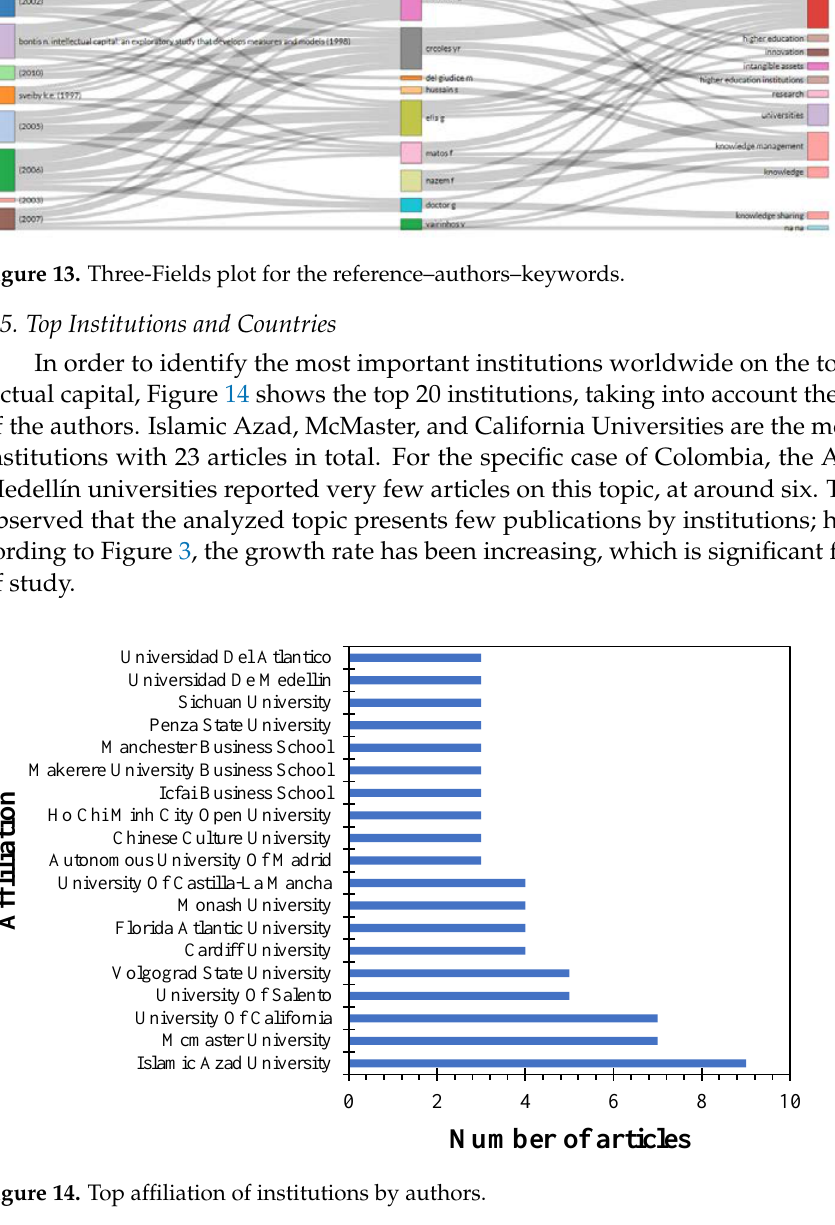
Figure 15. Frequency of appearance of countries and collaboration.